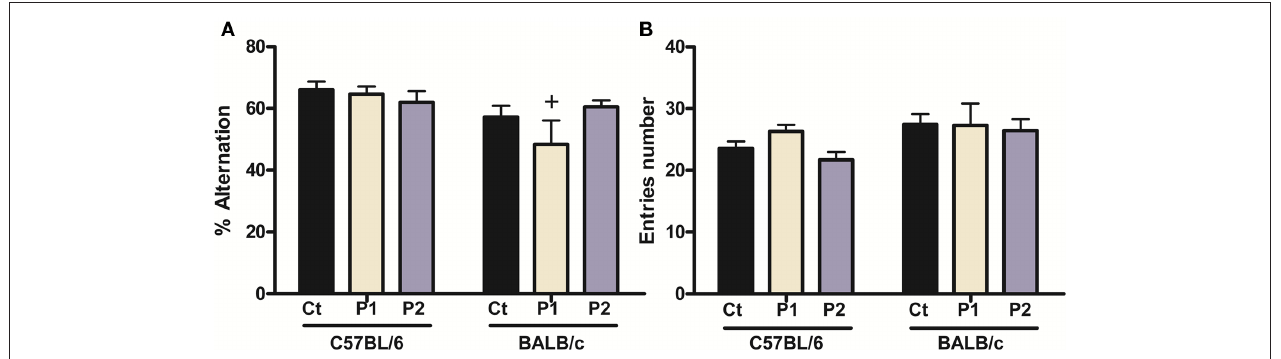
C57BL/6 mice alternating more than protocol 1 BALB/c mice. n = 11–19 per strain per stress condition. Data expressed as means ± SEM. Black “Ct,” control AFR groups;